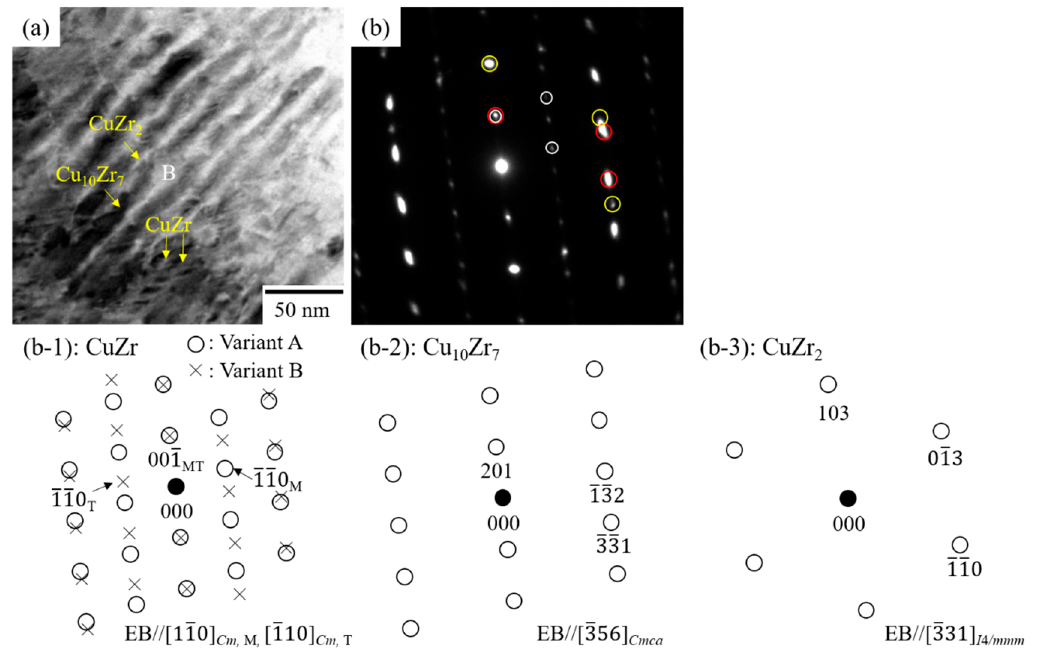
Figure 4. ( a ) Bright field images of 10th cycled equiatomic CuZr alloy, ( b ) electron diffraction